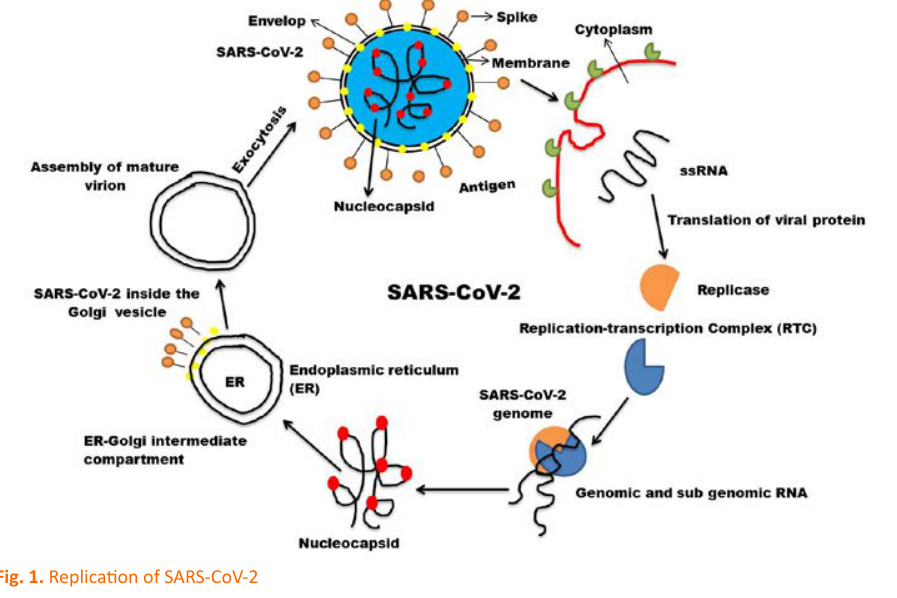
Fig. 1. Replication of